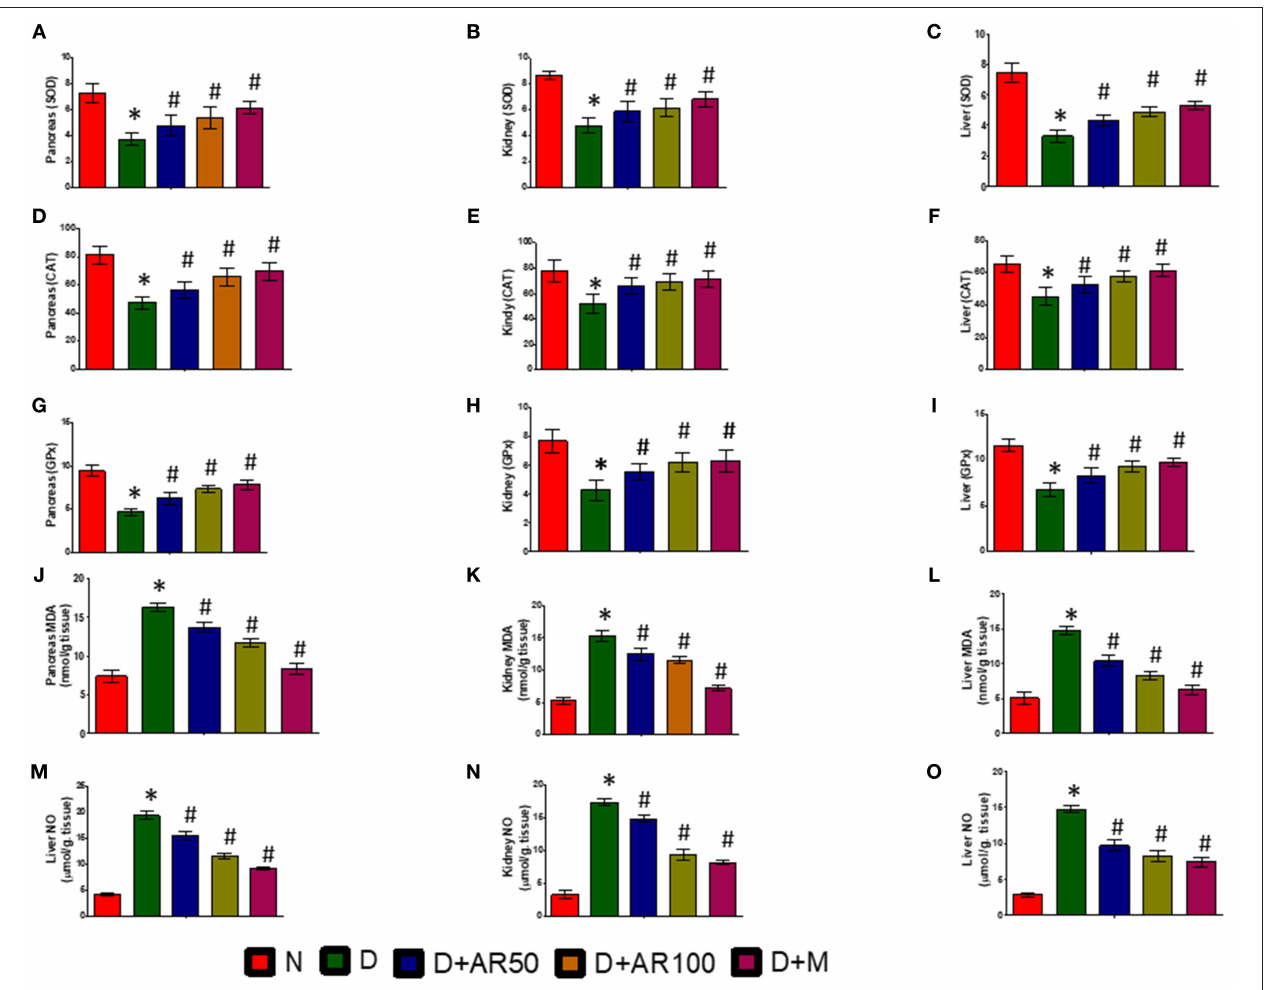
FIGURE 7 | Effect of Annona reticulata L on (A) Pancreas SOD (B) Kidney SOD (C) Liver SOD (D) Pancreas CAT (E) Kidney CAT (F) Liver CAT (G) Pancreas GPx (H) Kidney GPx (I) Liver GPx (J) Pancreas MDA (K) Kidney MDA (L) Liver MDA (M) Pancreas NO (N) Kidney NO (O) Liver NO. Each value is mean ± SD of six rats in each group.*significant compared to normal control group p < 0.01. # significant compared to diabetic group p <